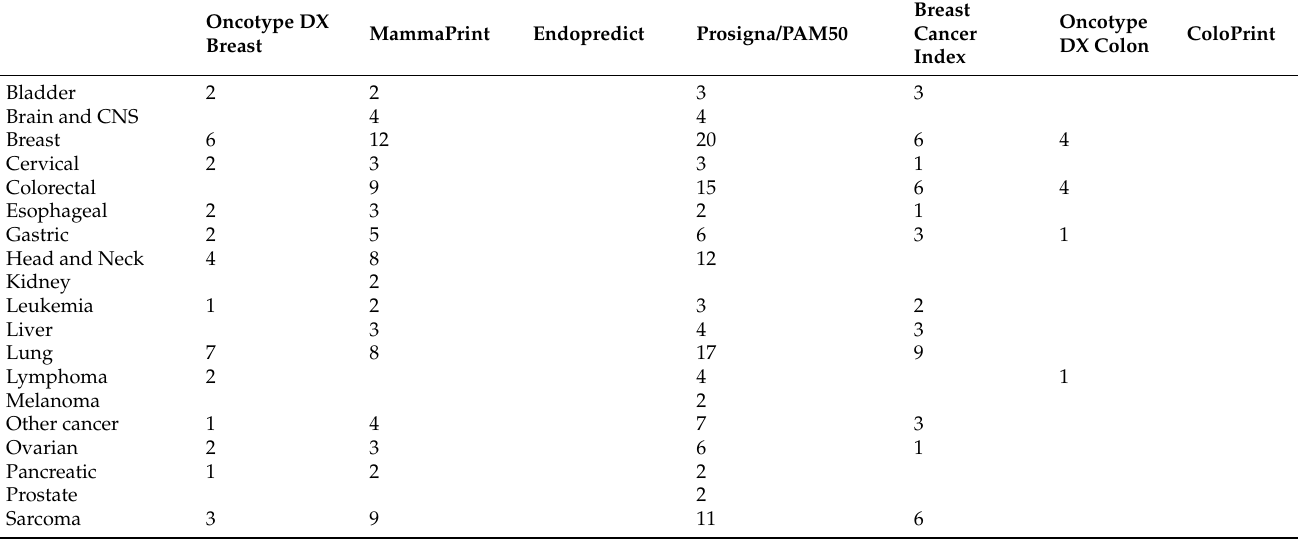
Table 4. Oncomine results of breast cancer and colorectal